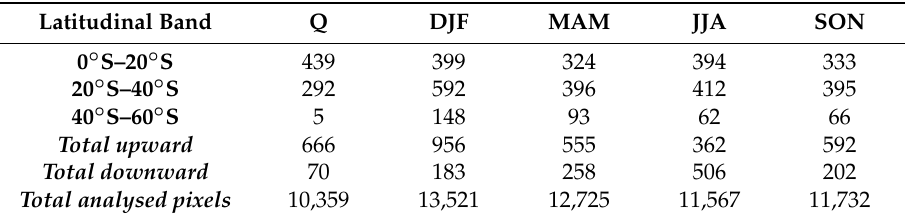
Table 2. As in Table 1 but for the SO 2 concentrations in the